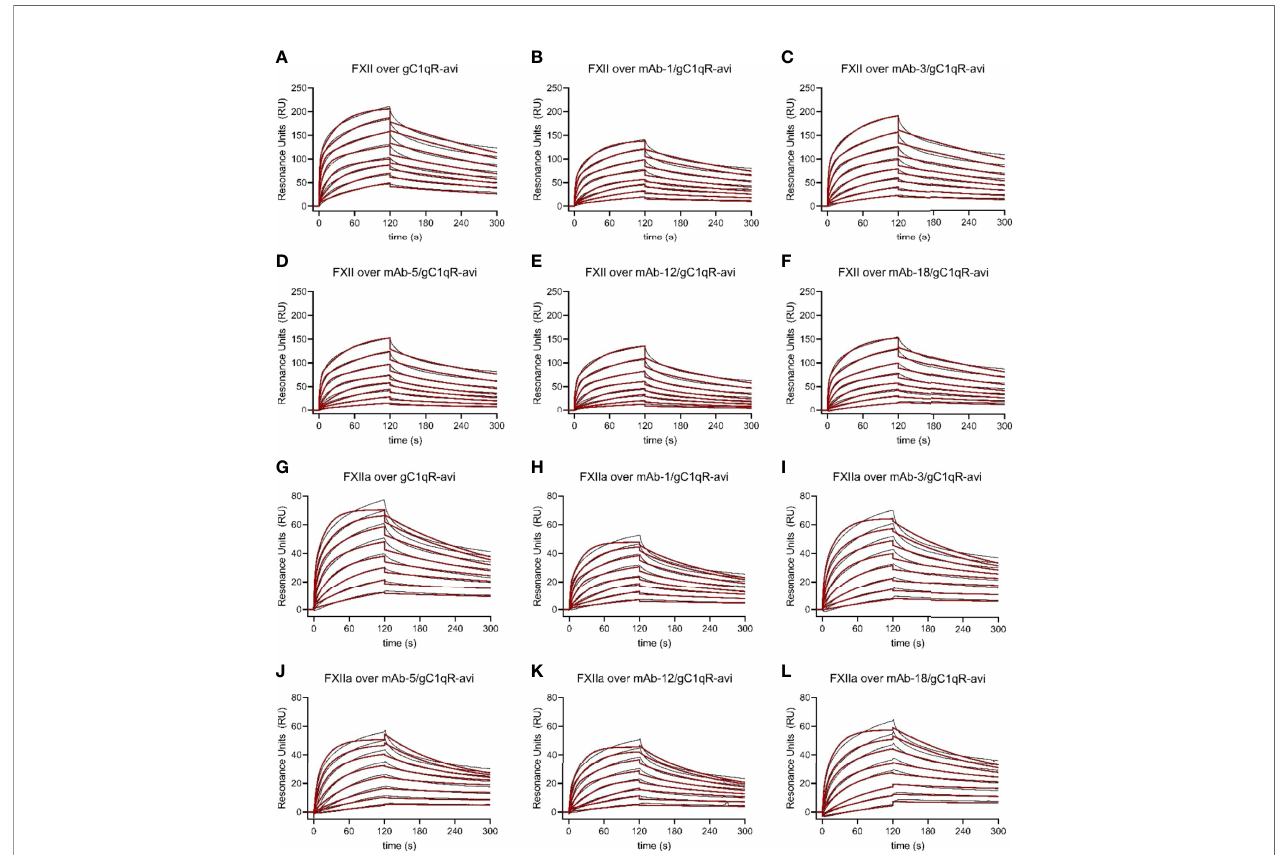
FIGURE 6 | Multiple anti-gC1qR Antibodies Interfere with Binding of Factor XII and Factor XIIa to gC1qR. Wild-type gC1qR was enzymatically biotinylated through a C- terminal avi-tag and captured to a density of ~100 RU on the experimental fl ow cells of a streptavidin-derivatized sensor chip. After con fi rmation of mAb binding to the captured gC1qR-avi using a single-cycle kinetic experiment ( Data Not Shown ), the impact of that mAb on FXII and FXIIa binding to gC1qR was assessed by pre-loading a single fl ow cell with saturating levels of the mAb followed by injecting various concentrations of FXII and FXIIa over all three experimental fl ow cells. (A) Dose-response sensorgram series (black traces) and fi ts (red traces) for injection of FXII over a gC1qR-avi surface. (B) Analogous to panel (A) , except with presaturation of mAb-1. (C) Analogous to panel (A) , except with presaturation of mAb-3. (D) Analogous to panel (A) , except with presaturation of mAb-5. (E) Analogous to panel (A), except with presaturation of mAb-12. (F) Analogous to panel (A) , except with presaturation of mAb-18. (G) Dose-response sensorgram series (black traces) and fi ts (red traces) for injection of FXIIa over a gC1qR-avi surface. (H) Analogous to panel (G) , except with presaturation of mAb-1. (I) Analogous to panel (G) , except with presaturation of mAb-3. (J) Analogous to panel (G) , except with presaturation of mAb-5. (K) Analogous to panel (G) , except with presaturation of mAb-12. (L) Analogous to panel (G) , except with presaturation of